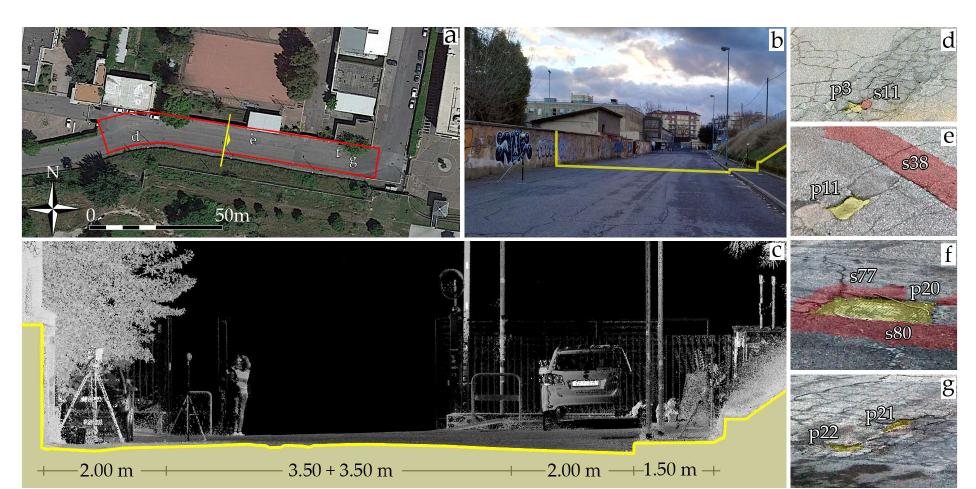
Figure 1. (a) Overview of the test site; the extracted stretch of road is outlined in red. (b) A picture of the road. (c) Road profile, along the section line drawn in yellow on the images shown in (a,b). (d–g) the road. ( c ) Road profile, along the section line drawn in yellow on the images shown in ( a , b ). ( d – g ) Pictures of a few potholes (P) and swells/shoves (S). Pictures of a few potholes (P) and swells / shoves